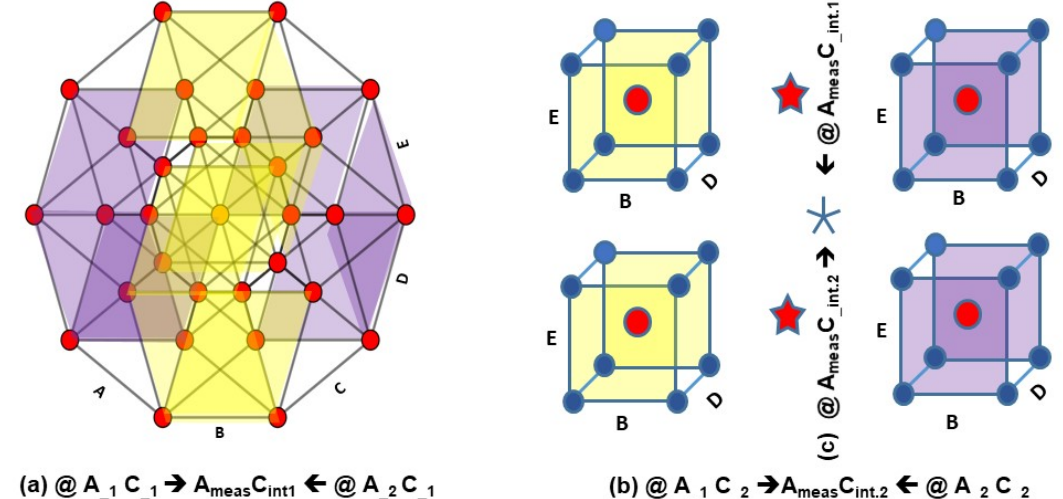
Figure 15. Penteract (Coxeter B4 projection) illustrating the {A,B,C,D,E} dataspace for five process parameters. An additional final interpolation step (c) is needed between sound velocity vs. {%Gas _1 in Gas_ 2 } concentration polynomial fit parameters already interpolated ( a ), ( b ) to points between their respective cube pairs. The dimension of the final interpolation (here, C ) depends on the pre-chosen pairs of cubic faces.